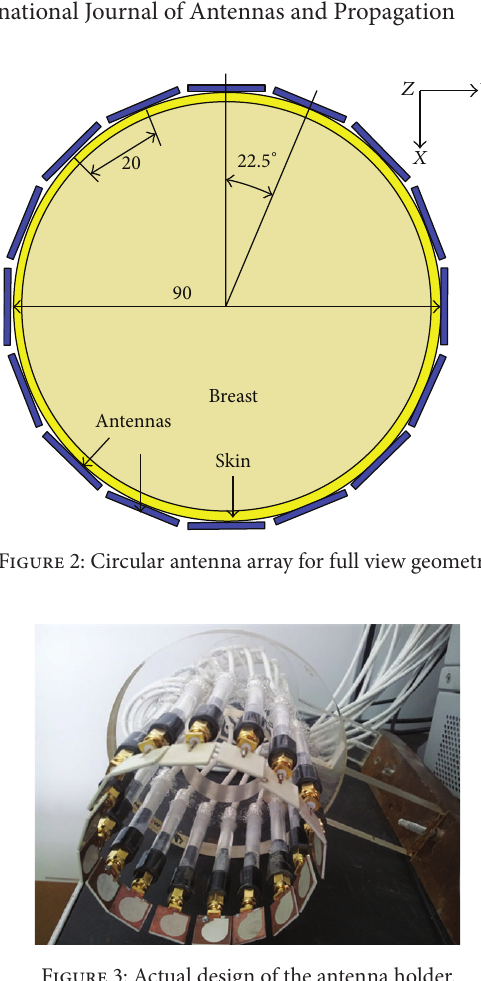
Figure 3: Actual design of the antenna holder.